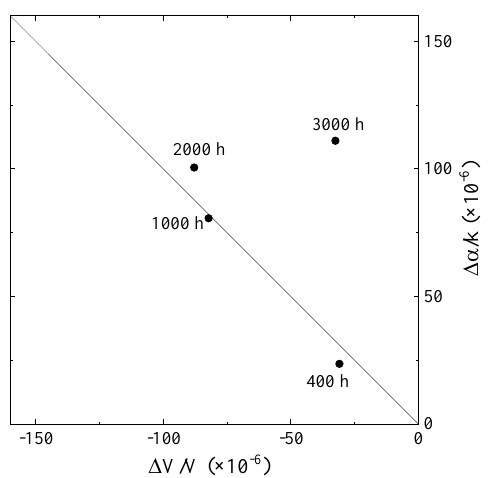
Figure 9. ( a ) Velocity and ( b ) attenuation changes obtained from Ch.1 as a function of heated time.